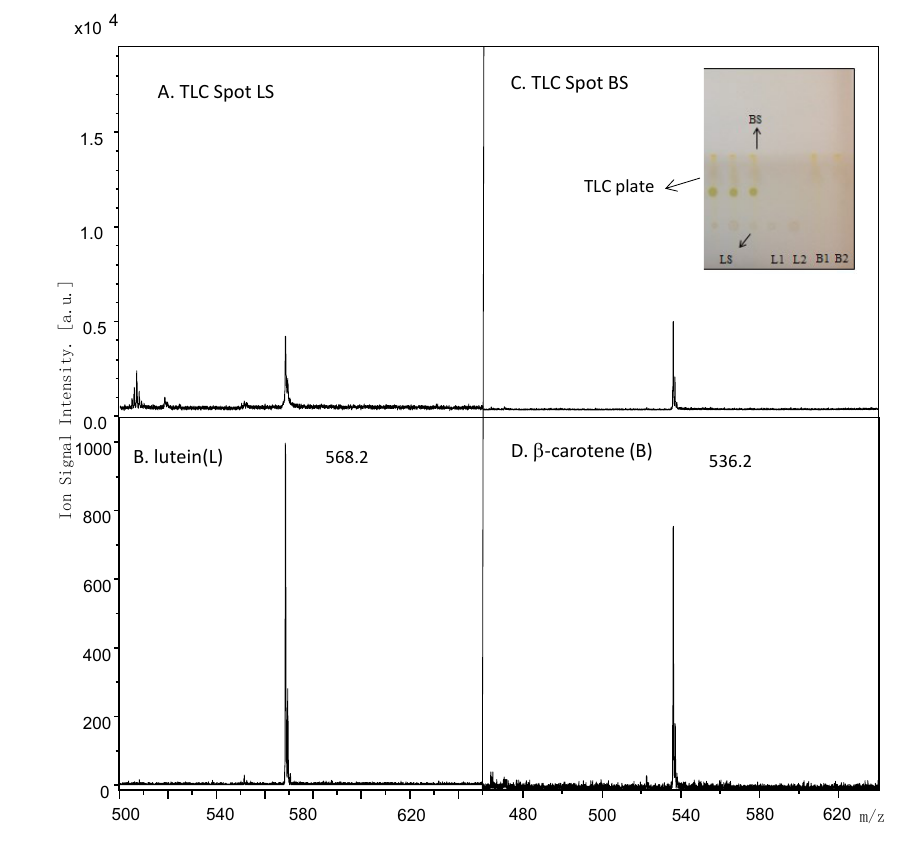
Figure 3. Mass spectra of spinach extract TLC spot LS of experimental condition (panel A ) and TLC spot BS of experimental condition (panel C ) excised and compared to lutein (panel B ) and β-carotene (panel D )